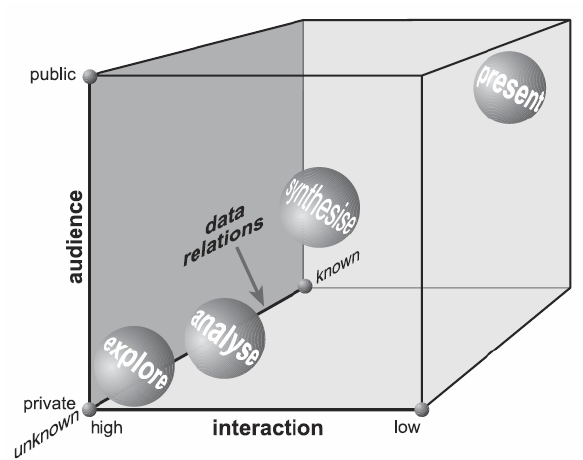
Figure 1: Map use cube and goals of map use (MacEachren